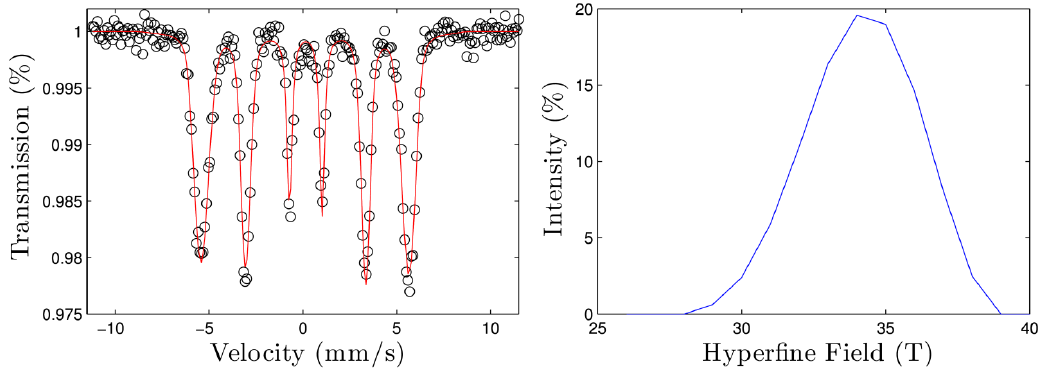
Figure 4. Collected Mössbauer spectra ( left ) with the experimental data (symbols) and the best fit (red line) and hyperfine magnetic fields distribution ( right